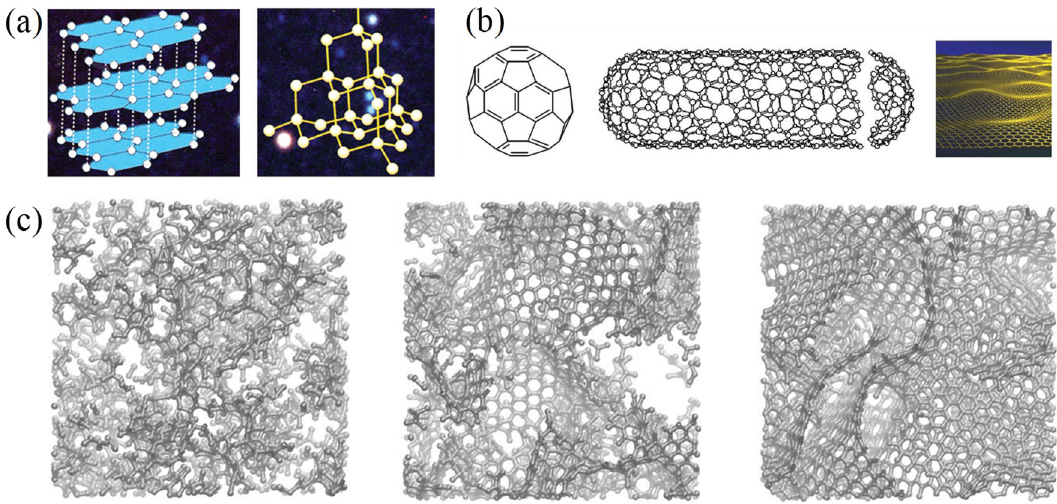
Figure 1. ( a ) Carbon modifications graphite (left) and diamond (right); ( b ) Structures of the carbon nanomaterials C 60 fullerene (left), single-walled carbon nanotube (middle), and graphene (right); ( c ) Model atomic structures of nanoporous carbon-based materials with different degrees of carbon ordering. ( a , b ) adapted from [10], with permission from Wiley, 2012. ( c ) adapted from [14], with permission from Elsevier, 2010.